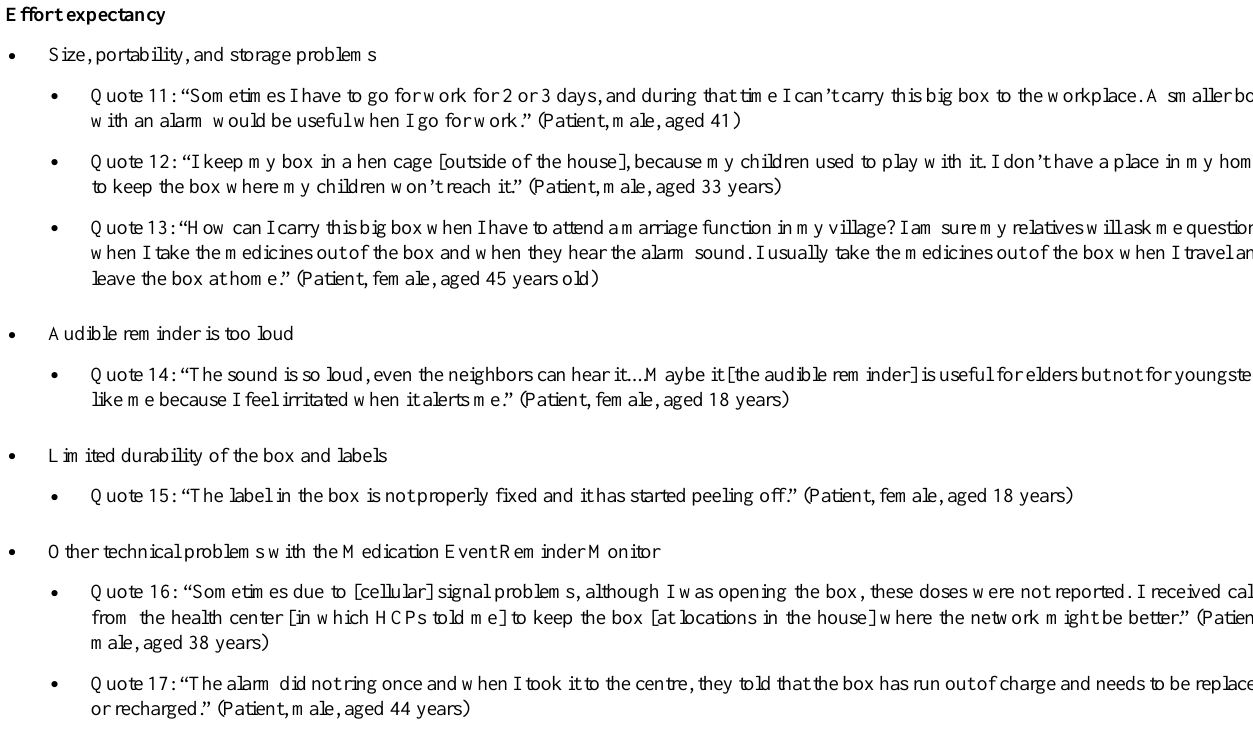
Textbox 2. Representative quotations on barriers to acceptance and use of the Medication Event Reminder Monitor by patients based on constructs in the Unified Theory of Acceptance and Use of Technology